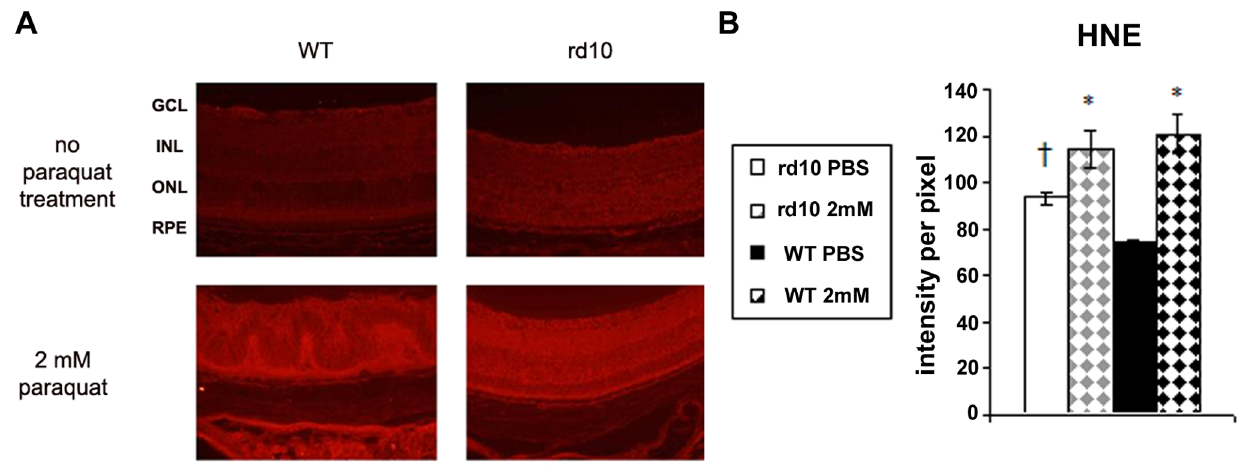
Figure 4. HNE staining of retina sections for assessment of oxidative injury following PQ injection. Retinas of rd10 and WT mice injected with 1 m l of 2 mM PQ or PBS were labeled with anti-HNE antibody ( red ; A). GCL= ganglion cell layer, INL=inner nuclear layer, ONL=outer nuclear layer, RPE= retinal pigmented epithelium. (B) Quantification of HNE staining intensity showed marked oxidative injury following PQ injection in WT and the rd10 mice (*p , 0.05 as compared to PBS injected eyes of same strain. { p=0.0002 comparing control (PBS) eyes between the strains; n=5 in each group).